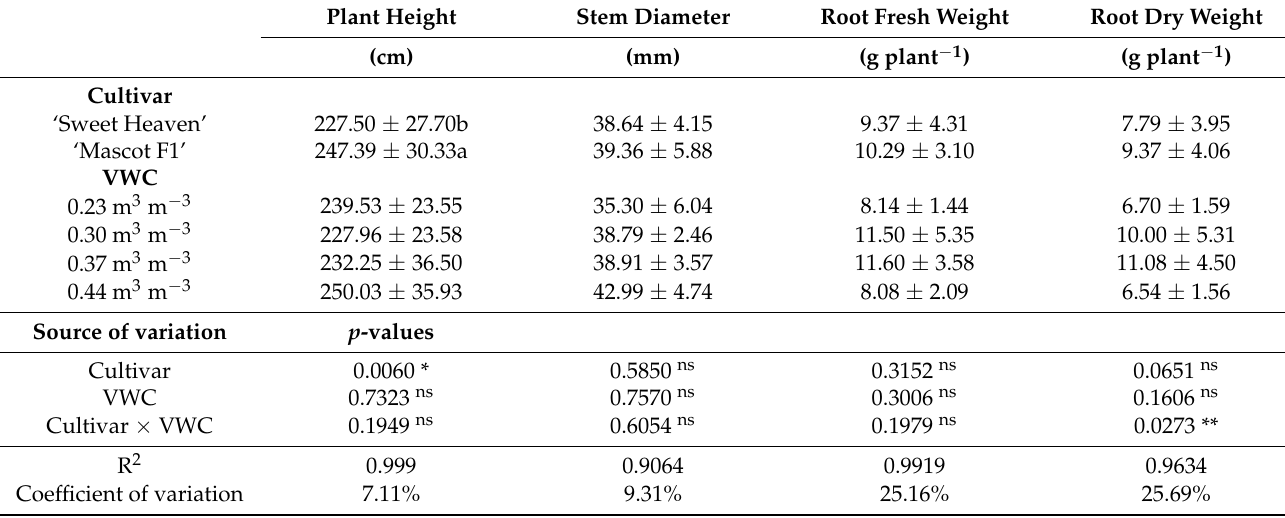
Table 1. Plant height, stem diameter, root fresh and dry weight of two cherry tomato cultivars in response to increasing volumetric water contents (VWC).